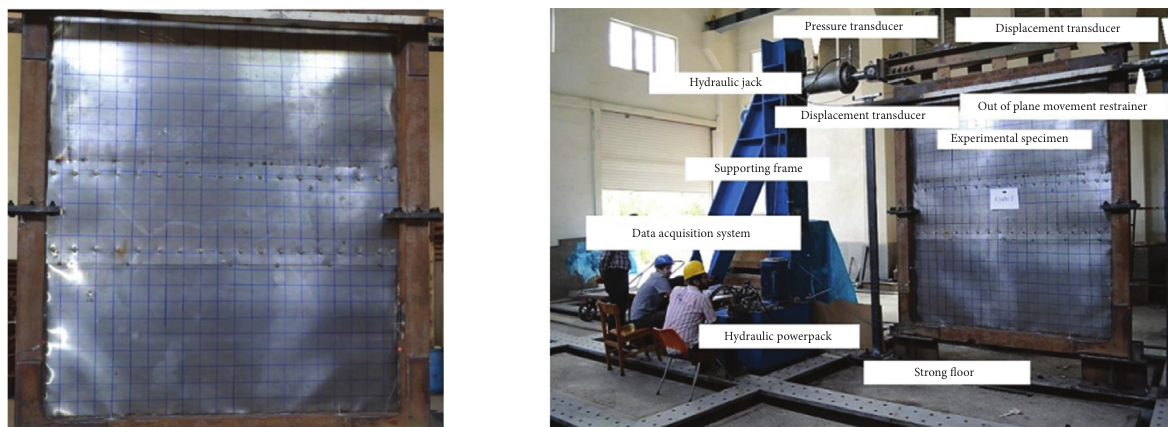
Figure 10: An overview of the laboratory model